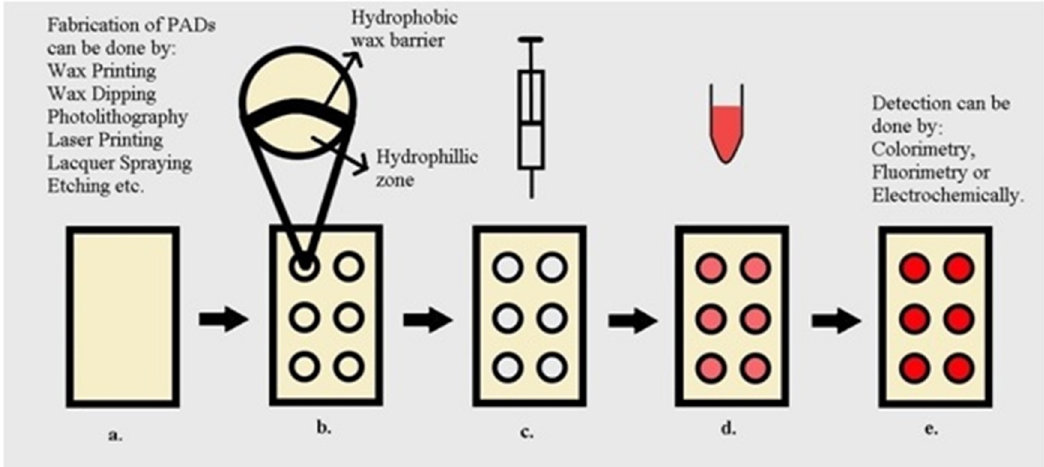
Figure 1: A typical micro fl uidic paper - based analytical device setup: ( a ) unfabricated Whatman fi lter paper, ( b ) fabricated PAD with distinct hydrophobic barriers and hydrophilic zones, ( c ) pre - loading of reacting reagents, ( d ) loading of sample on PAD, and ( e ) development of